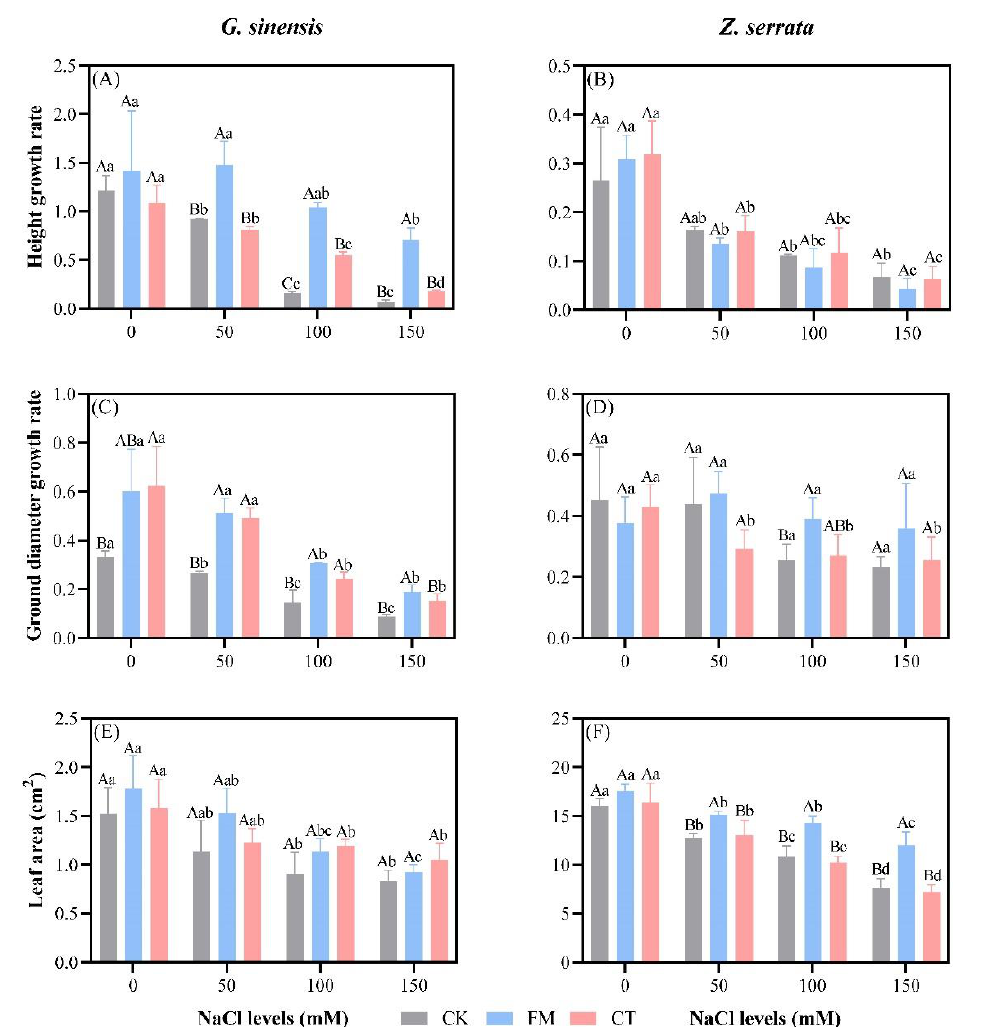
Figure 3. Variation in the height and ground diameter growth rate and leaf area between treatments. ( A ) height growth rate of G. sinensis different treatments; ( B ) height growth rate of Z. serrata different treatments; ( C ) ground diameter growth rate of G. sinensis different treatments; ( D ) ground diameter growth rate of Z. serrata different treatments; ( E ) leaf area of G. sinensis different treatments; ( F ) leaf area of Z. serrata different treatments. Uppercase letters indicate a significant difference between various inoculation treatments under the same salt levels ( p < 0.05). Lowercase letters indicate a significant difference between various salt concentrations under the inoculation treatments ( p < 0.05).